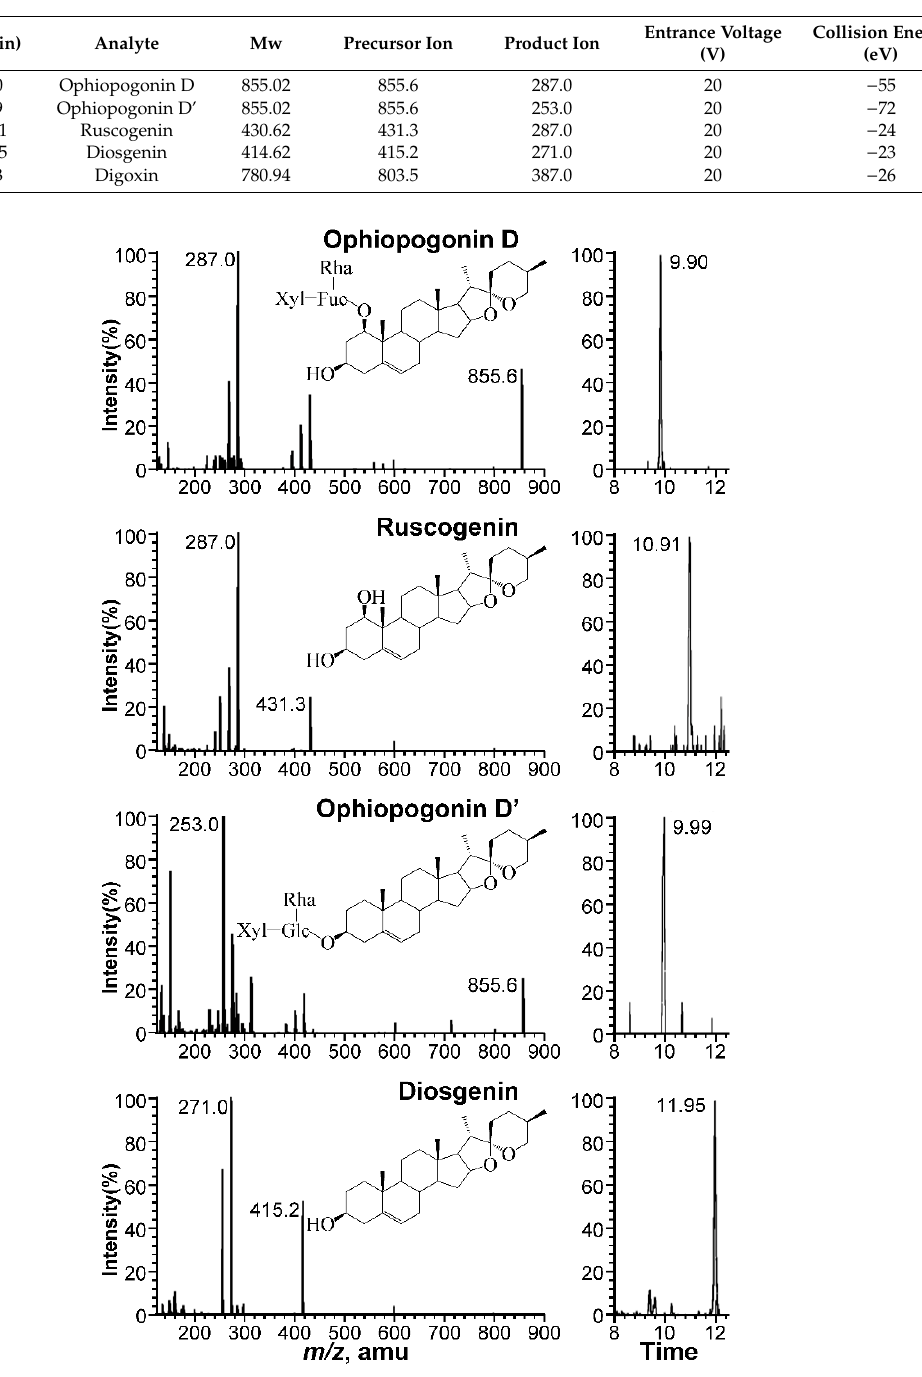
Figure 1. Chemical structure, representative MS/MS fragmentation spectrum showing precursor ion to product ion transitions, MRM chromatogram of blank broth solution spiked with each ophiopogonin at LLOQ (0.24 μM) of ophiopogonin D, ruscogenin, ophiopogonin D’ and diosgenin. Table 2. Linearity and sensitivity of UPLC-MS/MS assay for ophiopogonins in fermented broth of human gut microbiota.